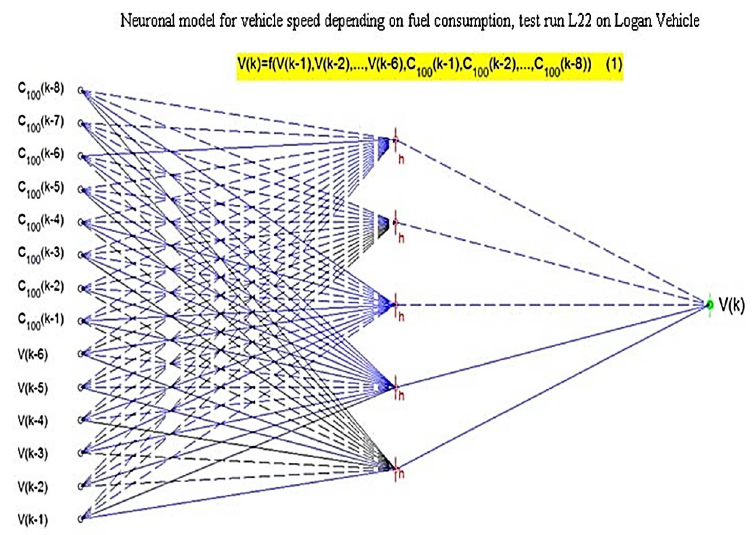
Figure 3. Neuronal network expressing vehicle speed.